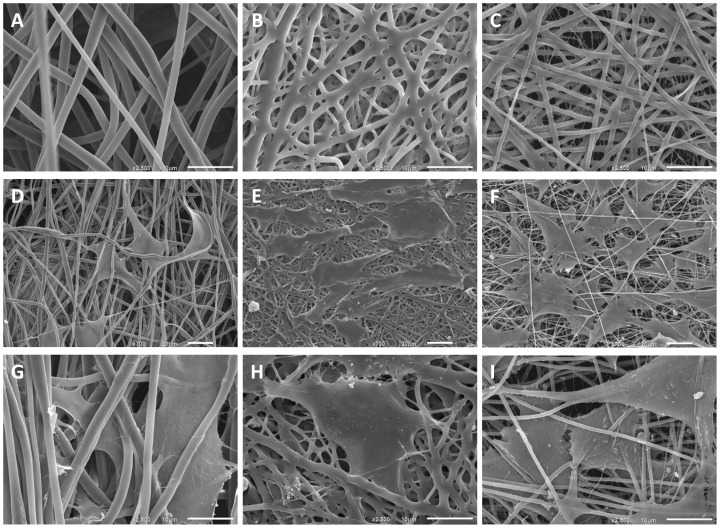
Ultrastructure analyses.SEM images of electrospun materials PEUU (A, D, G), PEU (B, E, H) and PLLA (C, F, I). Adipose derived stem cells were cultivated on top of the materials for 48 hours (D-I). Bars represent 10 µm (A, B, C), 20 µm (D, E, F), or 10 µm (G, H, I), respectively.